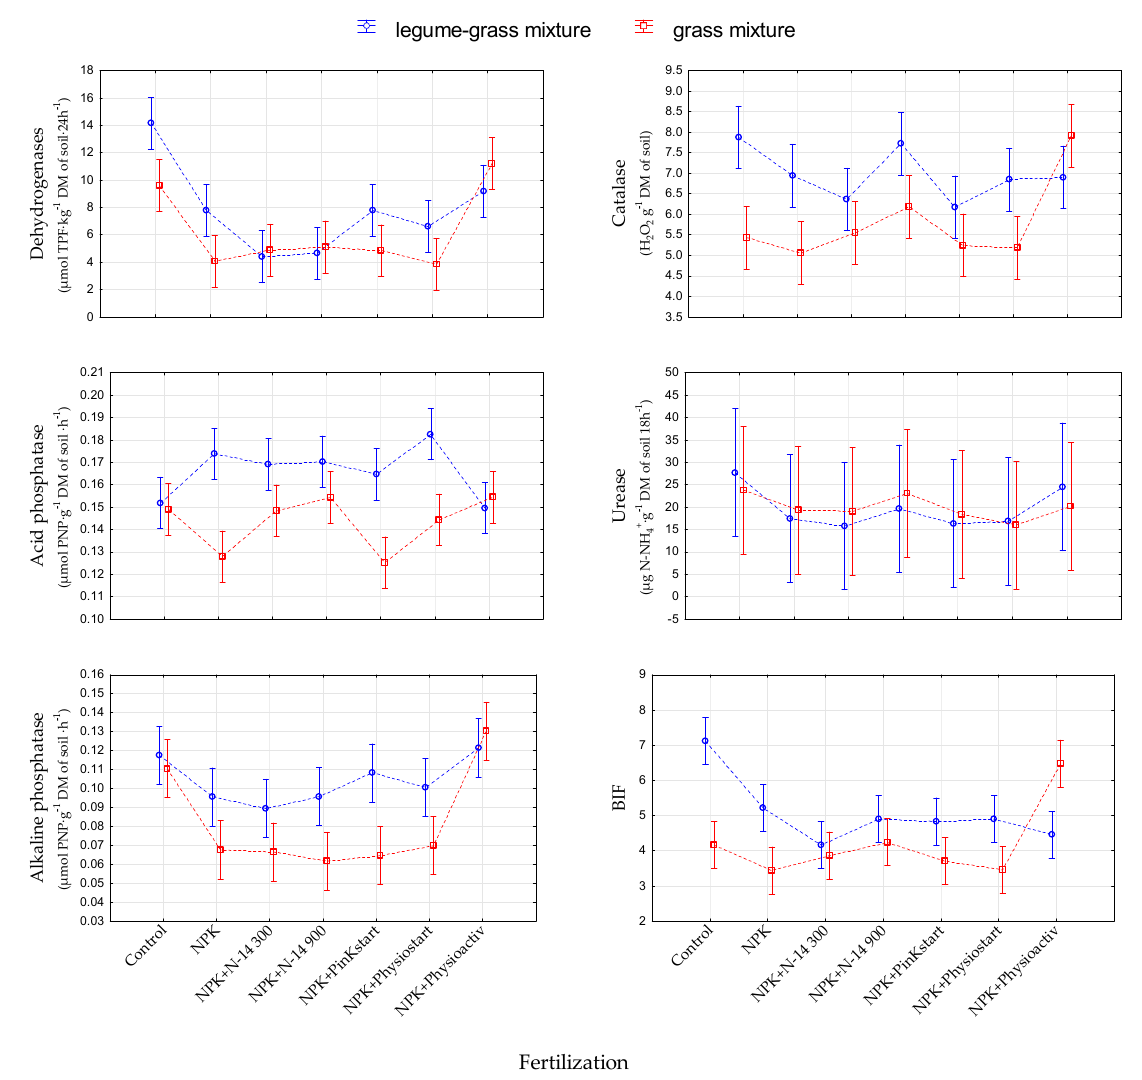
Figure 7. Soil enzymes activity in 2018–2019 (estimated marginal means and 95% confidence intervals in each experimental combination).